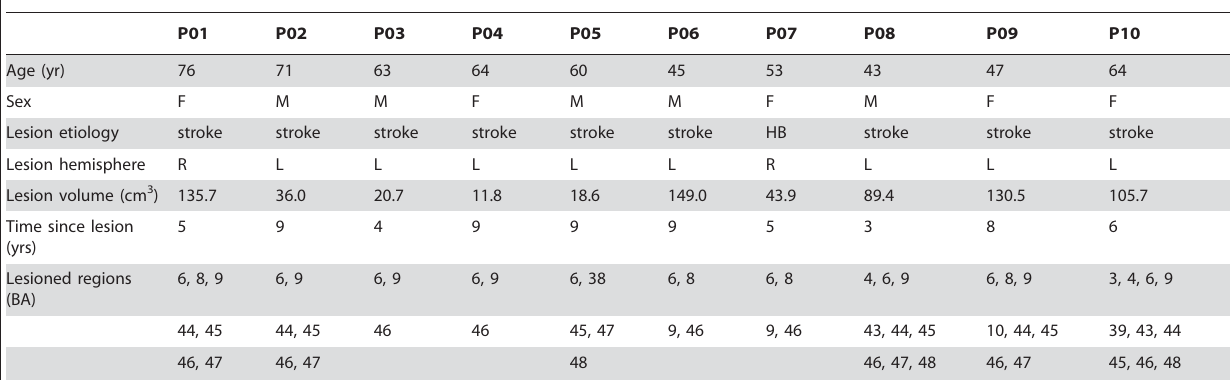
Table 1. Patient Demographics.